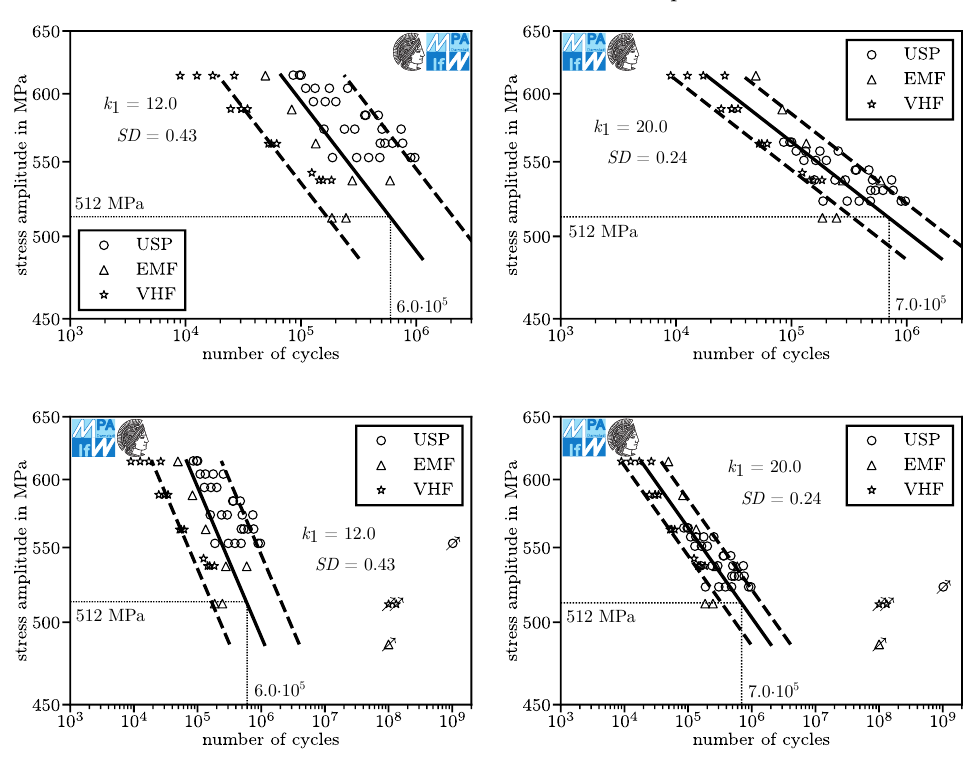
Figure 8. Fatigue behavior of 50CrMo4 in laboratory air; 919MPa ultimate tensile strength; K t = 1; Curves of 10, 50 and 90% probability of survival; run-outs are marked with an arrow; left side: before correction; right side: after correction; top: only HCF region; bottom: including VHCF